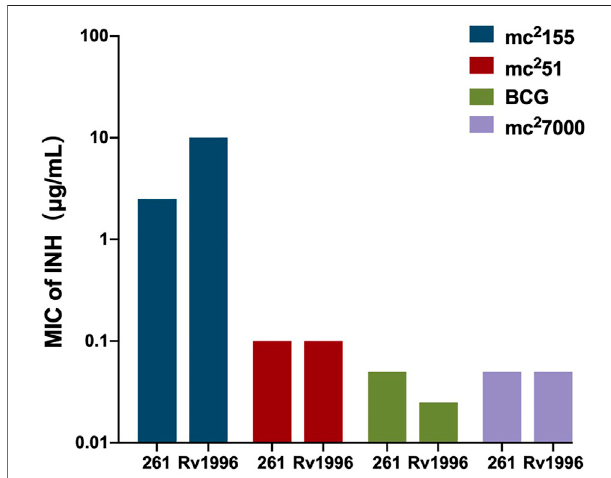
FIGURE 6 | Comparison of isoniazid susceptibility in different mycobacterial strains harboring pMV261- rv1996 and the corresponding control strain harboring pMV261.The minimum inhibitory concentrations (MICs) of isoniazid were determined by inoculating each bacterial strain in 7H9 containing serially isoniazid (INH). The values of MIC were recorded. 261 present pMV261. Rv1996 present pMV261- rv1996 . The image represents the results of three independent